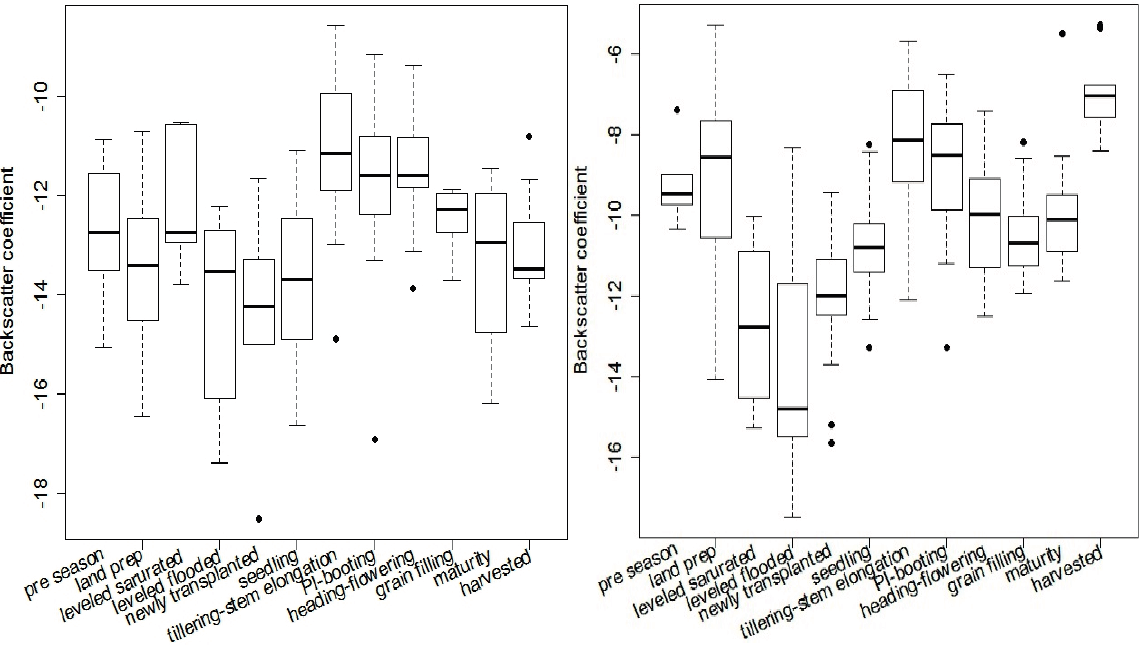
Figure 5. Boxplots of the backscatter coefficient derived from CSK (left ) and TSX ( right ) for each observed land preparation and growth stage at the monitored sites. The black dots represent the outliers, the thick horizontal black line in the middle of the box is the median, the upper half of the box is the 25th percentile and the lower half is the 75th percentile, and the extent of dashed lines represent the minimum and maximum.